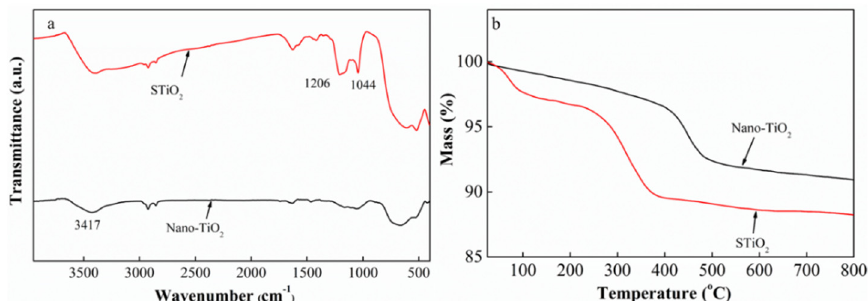
Figure 2. FTIR ( a ) and TGA analysis of TiO 2 and STiO 2 particles ( b ). Table 1. Thermal properties of TiO 2 and STiO 2 from TGA analysis .